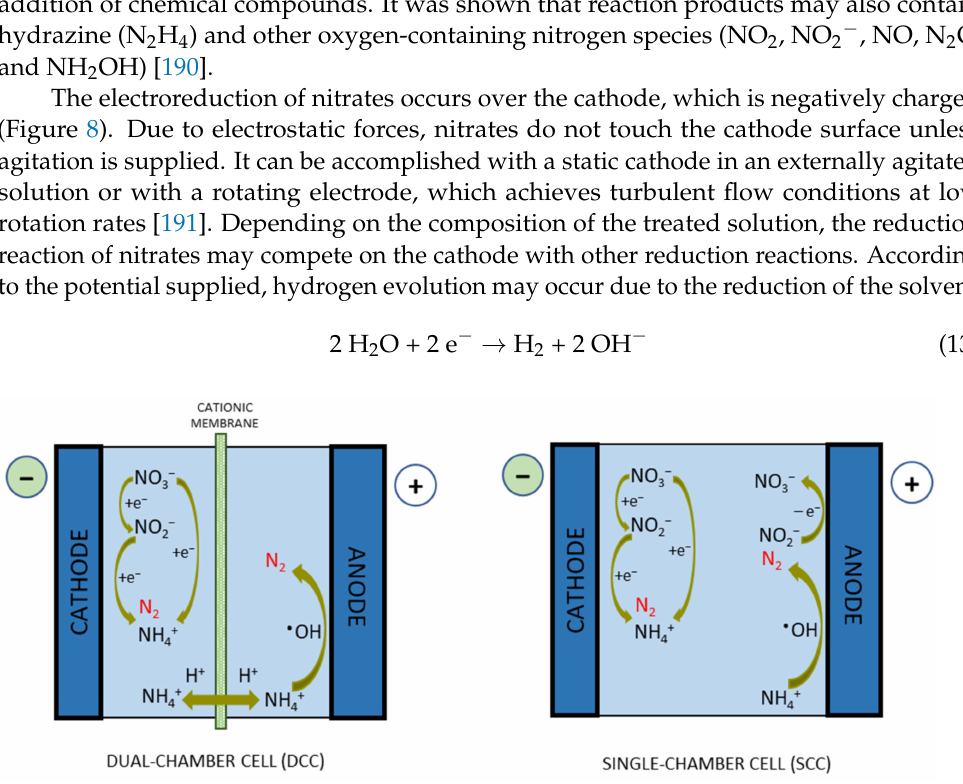
Figure 8. Electrochemical reduction of nitrate ions in dual- and single-chamber